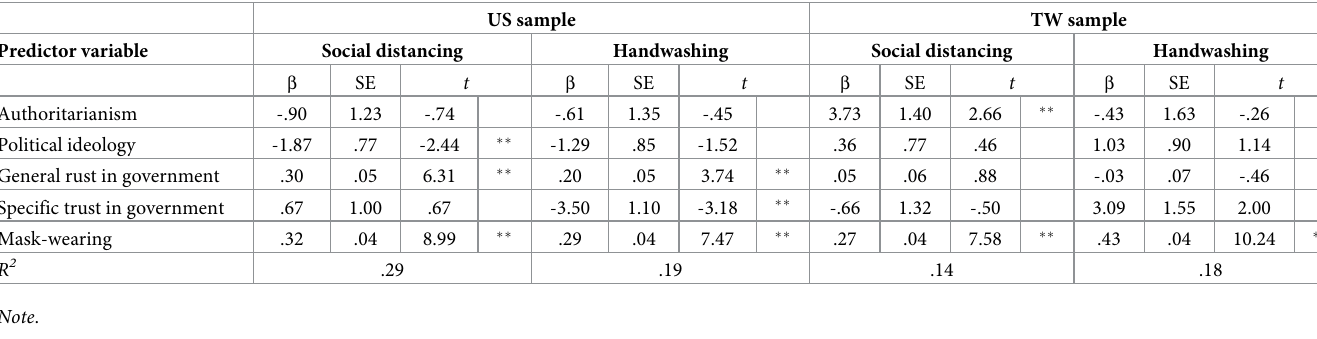
Table 2. Results of regression analysis for US and TW